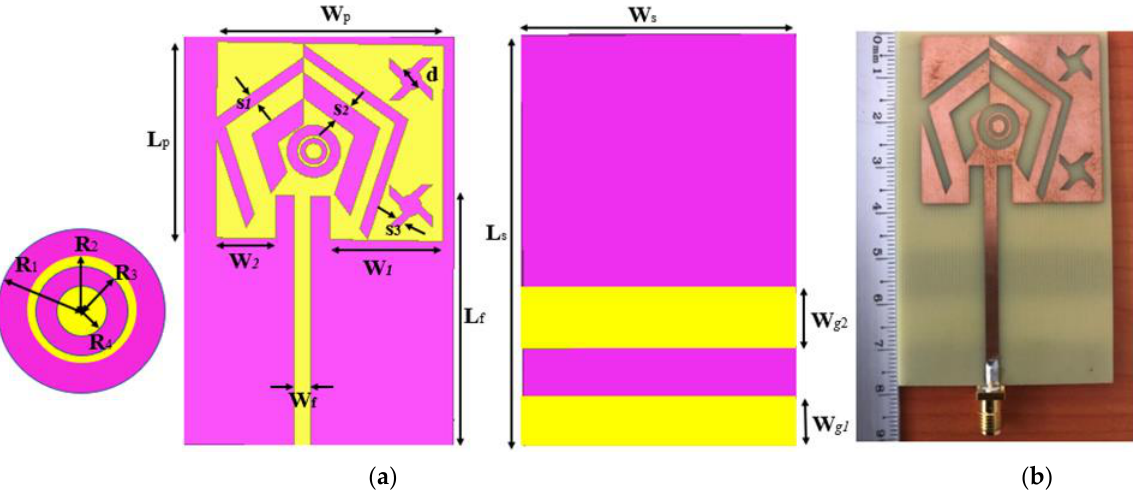
Figure 8. Proposed tri-band antenna: ( a ) optimized design; ( b ) photo of the fabricated prototype. Table 3. Detail of Antenna dimensions.